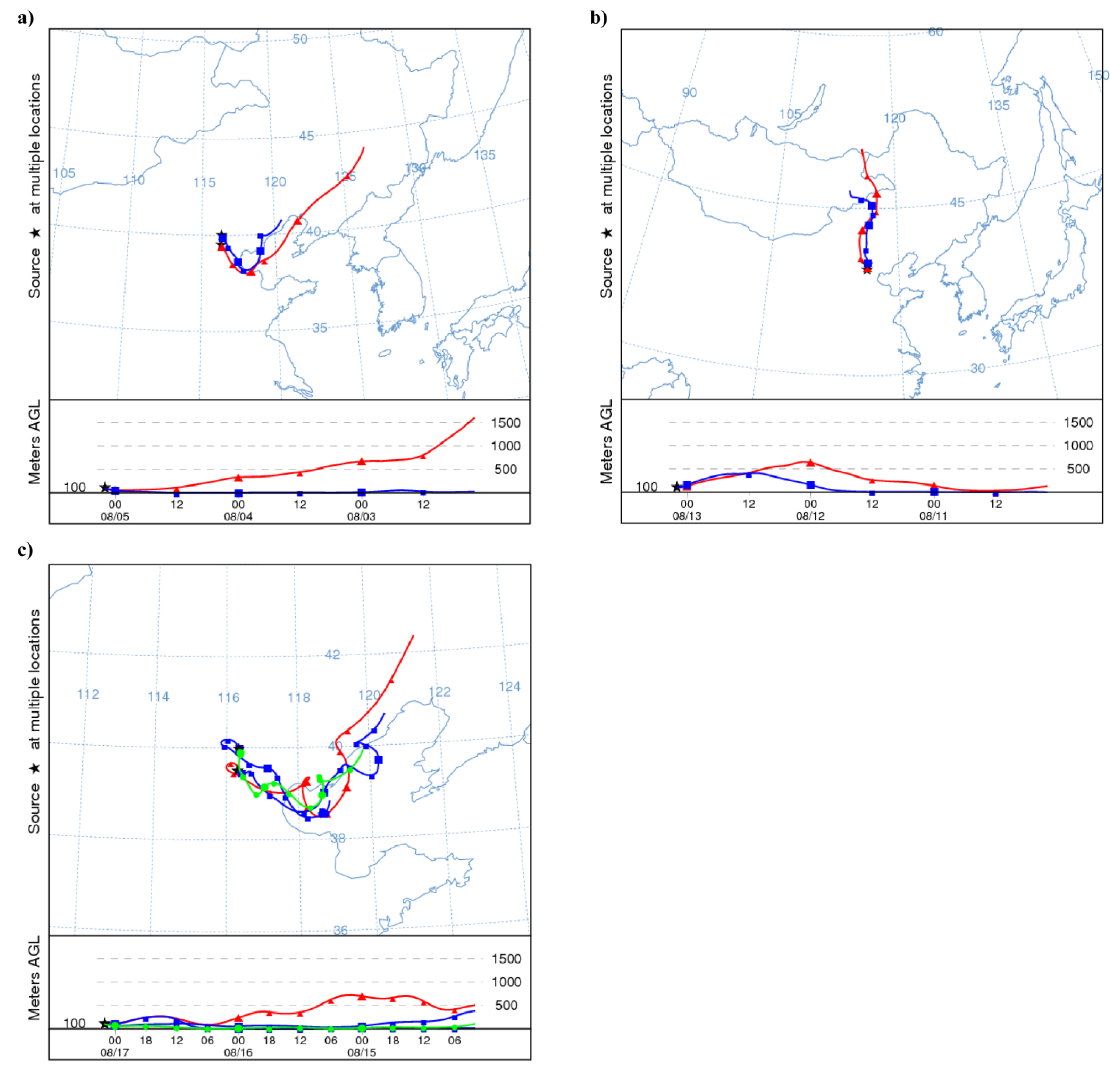
Figure 2. Three-day air mass back trajectories on (a) 05 August, (b) 13 August and (c) 17 and 19 August.